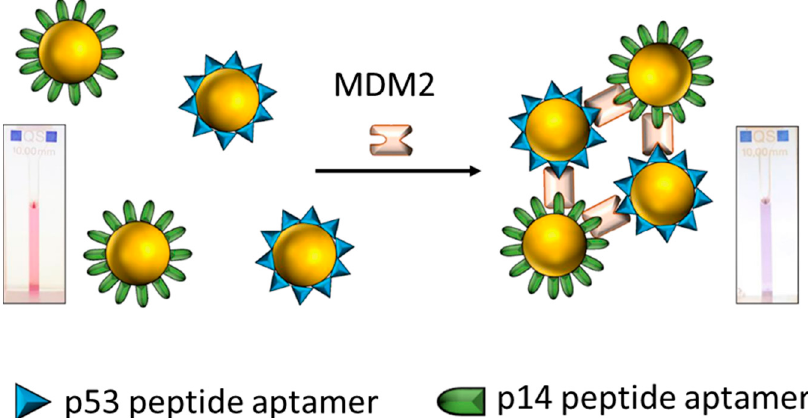
Figure 2. The schematic representation of the detection of Mdm2 using two peptide aptamer- functionalized AuNPs. After the addition of Mdm2, the aggregation of the AuNPs was driven by the formation of a ternary complex of Mdm2, p53, and p14, and the color of the solution changed from red to blue. Reproduced with permission from [37]. American Chemical Society, 2017.